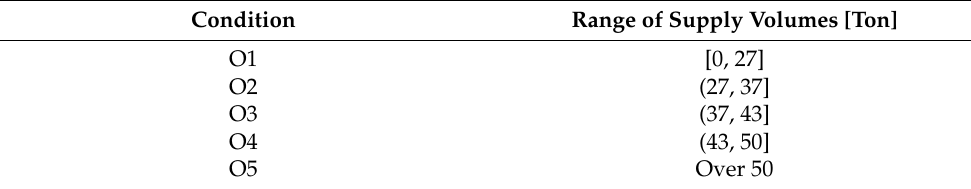
Table 1. Range of supply volumes assigned to the individual observed states.